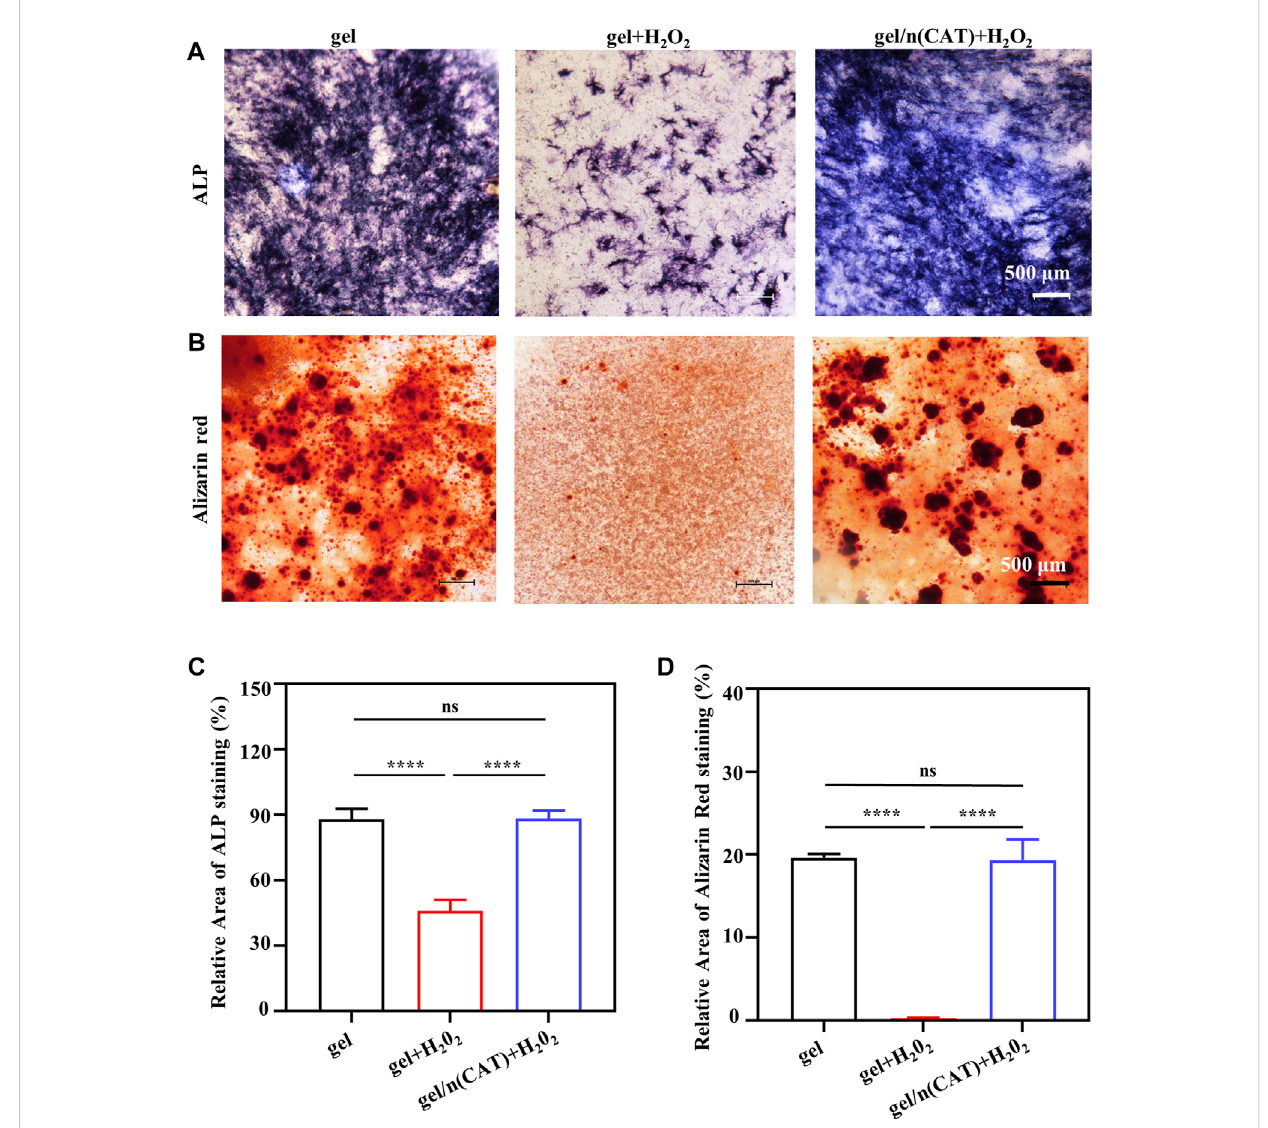
FIGURE 4 Osteogenic differentiation of osteoblasts by gel-n (CAT) in a persistent chronic in fl ammatory environment in vitro . (A) ALP staining of induced BMSCs for 7 days. (B) Alizarin Red Staining of induced BMSCs for 14 days. (C) Quantitative analysis of ALP and (D) Alizarin Red Staining images were analyzed by ImageJ software. (n = 3, ns means that there are no signi fi cant differences, **** p <